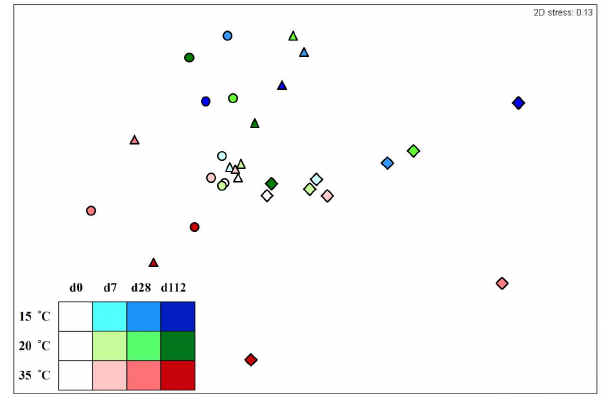
Figure 6. NMDS analysis of bamboo soil bacterial communities sampled at three elevations and incubated at different tempera- tures. Circles, triangles, and diamonds represent communities at 600, 1200, and 1800m elevation, respectively. The analysis was based on the distribution of OTUs formed at an evolutionary dis- tance of 0.03.